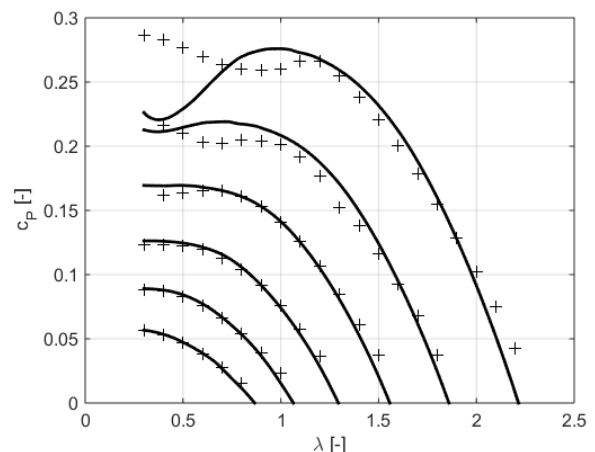
Figure A3. Comparison of computed values of thrust coefficient c T (solid lines) with experimental results from [8] (discrete points) for the three-blade propeller 5868-R6.